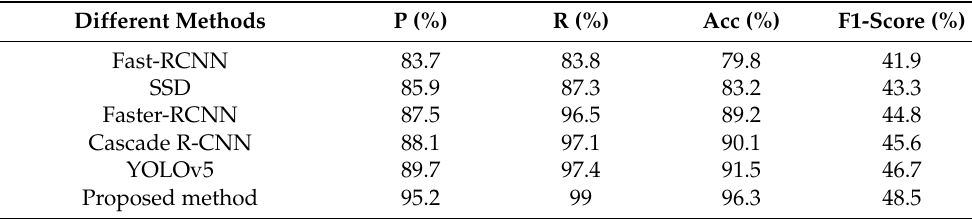
Table 6. Quadri-partite measures of different methods.